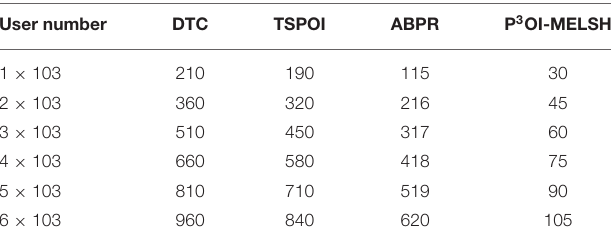
TABLE 1 | Running time comparison with different user number (unit/s).